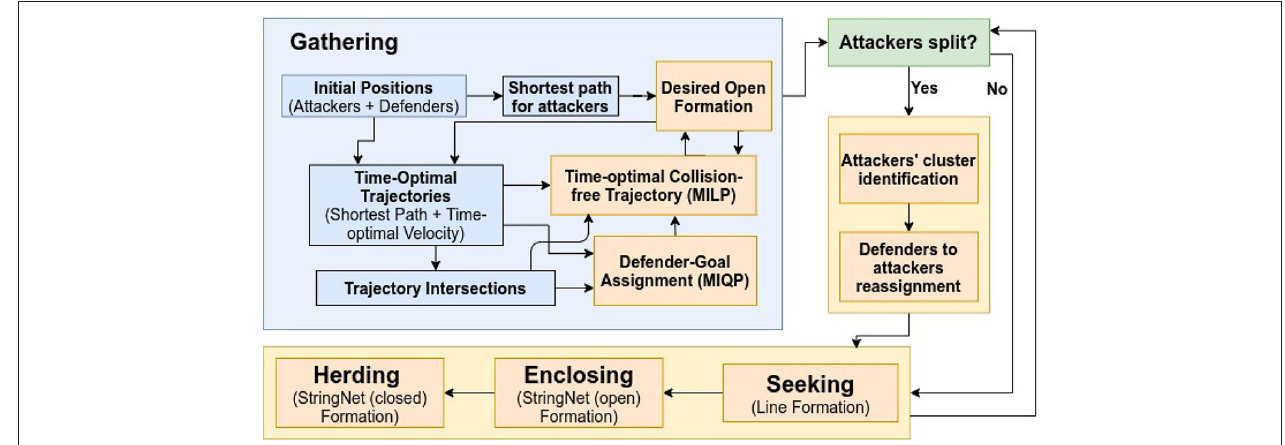
FIGURE 4 | Block diagram for “Multi-Swarm StringNet